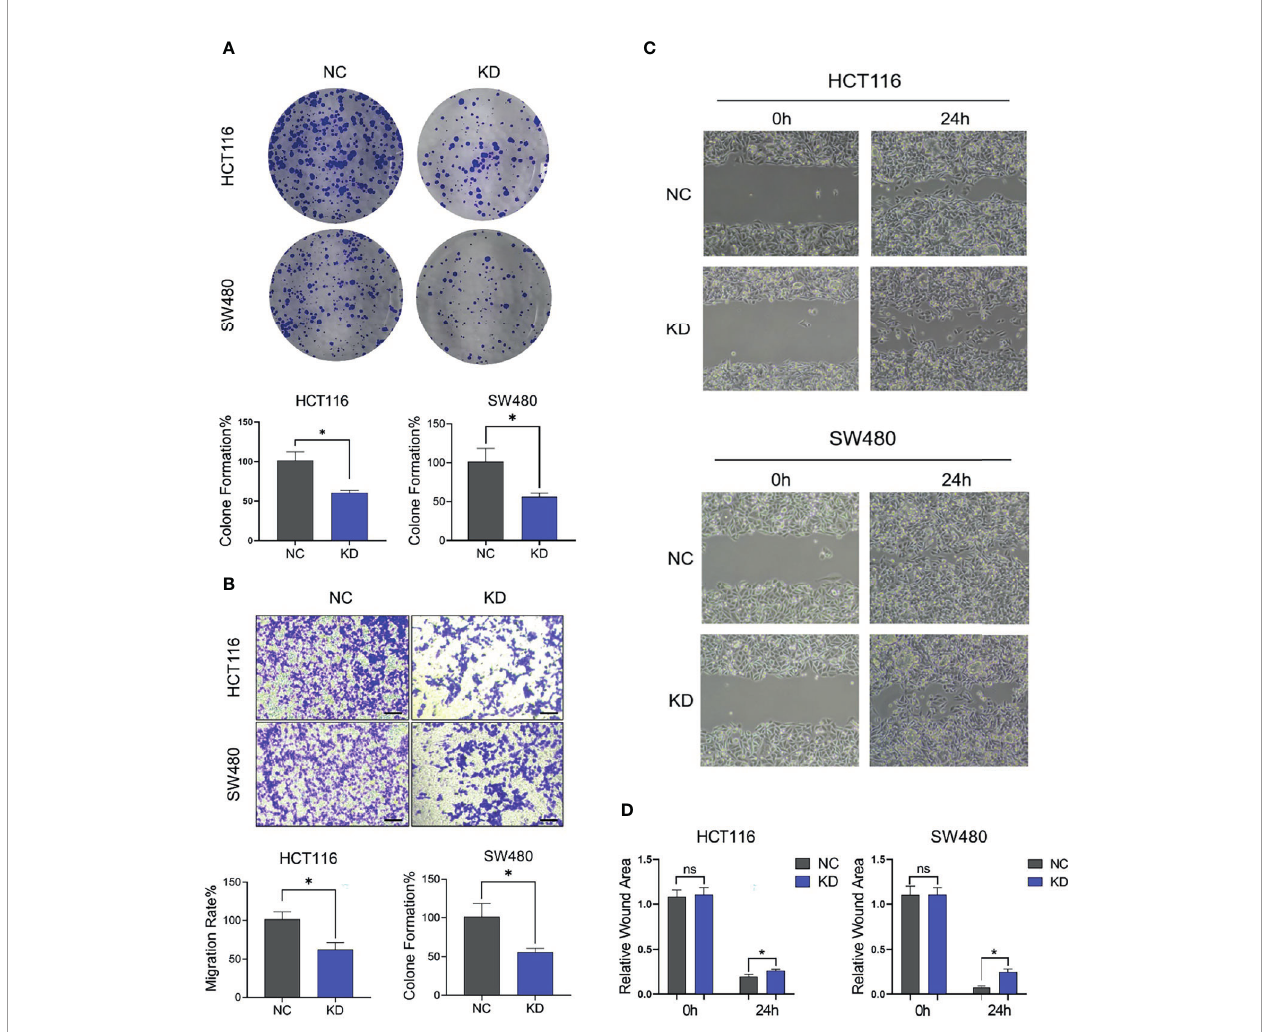
FIGURE 7 | FGF1 promotes proliferation and migration ability of CRC cells. (A, B) Colony formation capacity (A) and migration rates (B) of FGF1-KD CRC cells. CRC, colorectal cancer. (C) Wound healing assays were carried out at 24h after transfection in 6-well plates. The gap width was measured using Open Lab software. (D) The wound rate was calculated and displayed graphically according to the measured results by Open Lab software. NC, negative control; KD, FGF1- shRNA. Data are presented as mean ± SD (n=3). Ns, no signi fi cance, * P <